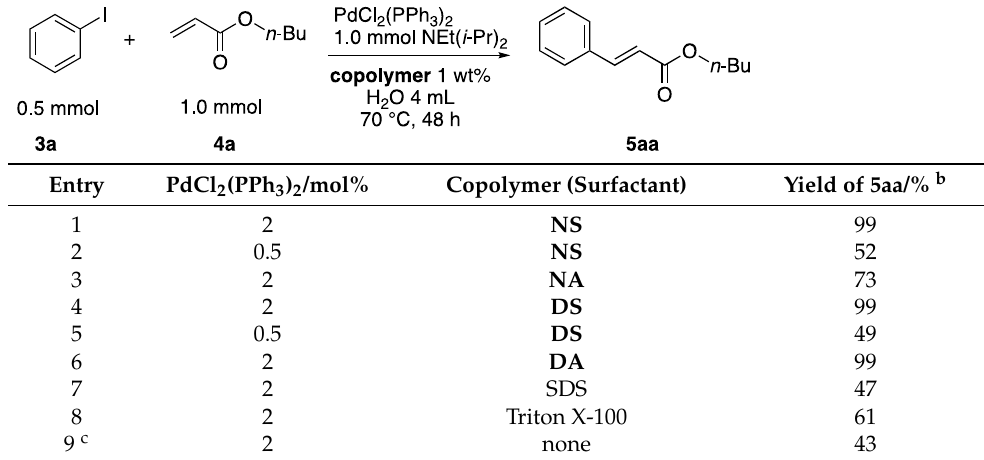
Table 1. Mizoroki–Heck reaction in water using the copolymers a .